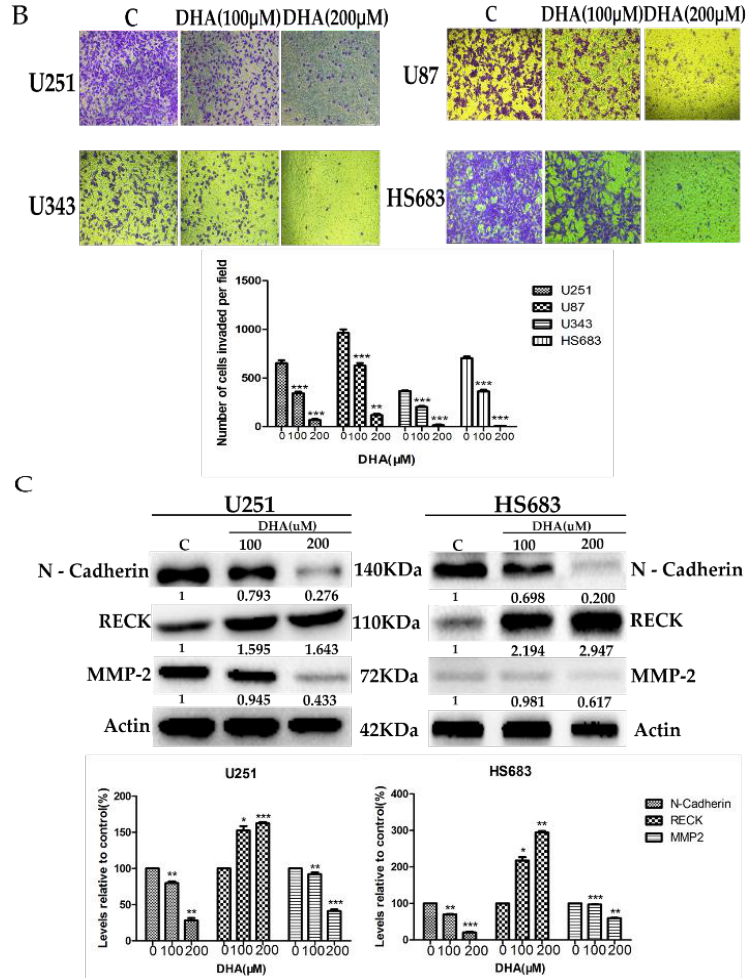
Figure 4. Inhibitive effect of DHA on the metastasis and invasion of malignant glioma cells by upregulating RECK (reversion-inducing-cysteine-rich protein with kazal motifs). ( A ) The inhibitive effects of DHA on malignant glioma cells migratory ability. Values were mean ± SD ( n = 3), ** p < 0.01,